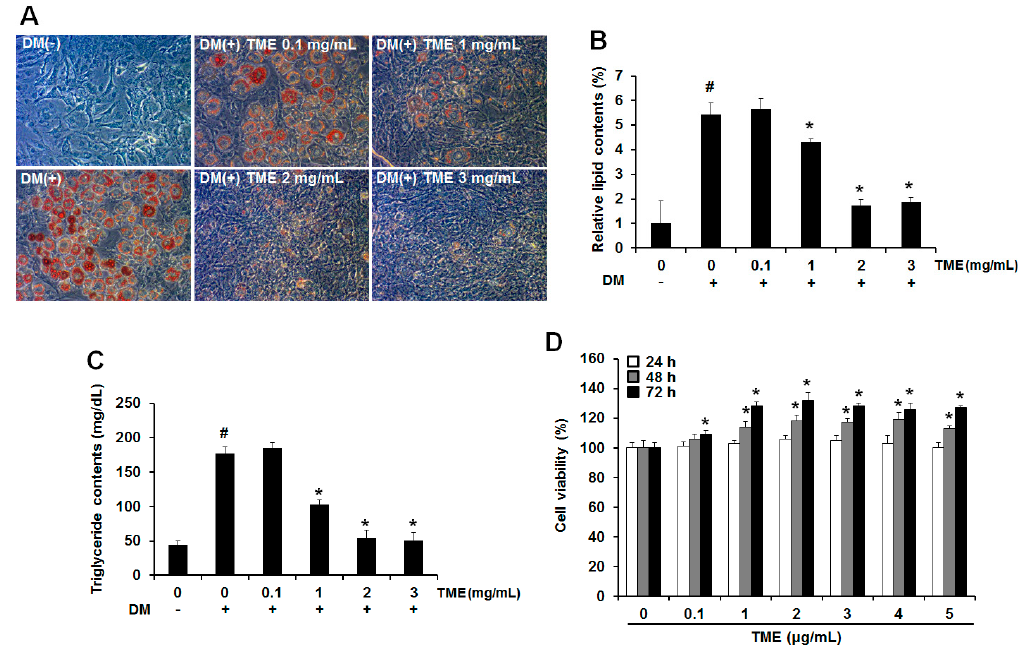
Figure 1. Antiadipogenic effect of ethanol extracts of Tenebrio molitor larvae (TME) on 3T3-L1 adipocytes. ( A ) Effect of TME on differentiation of 3T3-L1 adipocytes. 3T3-L1 adipocytes were cultured in adipocyte differentiation medium (DM) with or without treatment of TME. After 8 days of culture, cells were stained with Oil-Red O and photographed under a microscope (magnification: 40 × ). ( B ) Relative lipid contents and ( C ) Triglyceride (TG) content in different treatment groups. Results are presented as mean ± standard deviation (SD) of triplicate. # p -value of <0.05 indicates significant difference from non-differentiated control. * p -value of <0.05 indicates significant difference from differentiated control without TME. ( D ) Cytotoxicity of TME was determined using 3-(4,5-dimethylthiazol-2-yl)-5-(3-carboxymethoxyphenyl)-2-(4-sulfophenyl)-2H-tetrazolium (MTS) assay. Cells were seeded at a density of 2 × 10 5 cells/mL in a 96 well-plate and treated with TME for 72 h. Results are presented as mean ± SD of triplicate. * p -value of <0.05 indicates significant difference from differentiated control without TME.